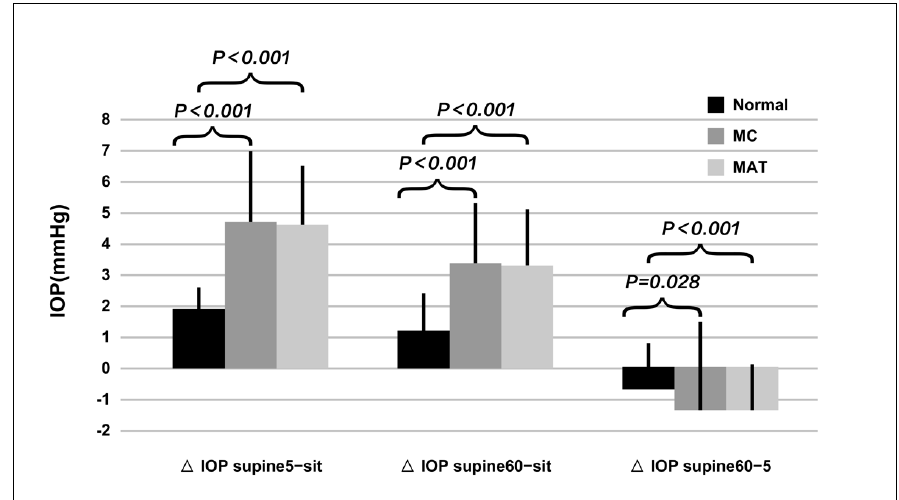
Figure 2. Comparison of intraocular pressure changes induced by postural alterations. Note: CP: canaloplasty, MAT: microcatheter assisted trabeculotomy. Δ IOP Supine 5-sit: The IOP difference between subjects lying for 5 min and in sitting position, Δ IOP Supine 60-sit: The IOP difference between subjects lying for 60 min and in sitting position, Δ IOP Supine 60-5: The IOP difference between subjects lying for 60 min and lying for 5 min.